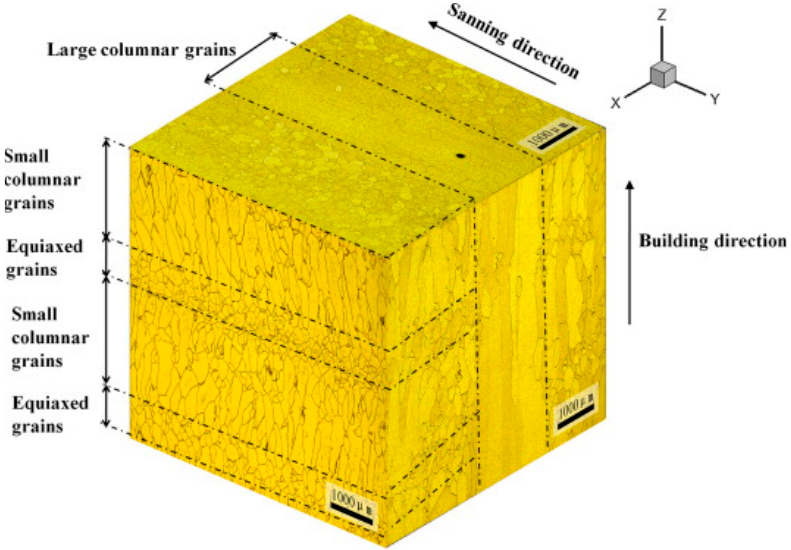
Figure 26. The “bamboo-like” grain morphology in an LP-DED Ti-5Al-5Mo-5V-1Cr-1Fe alloy (reproduced with permission from [132]; Copyright © 2013 Elsevier).